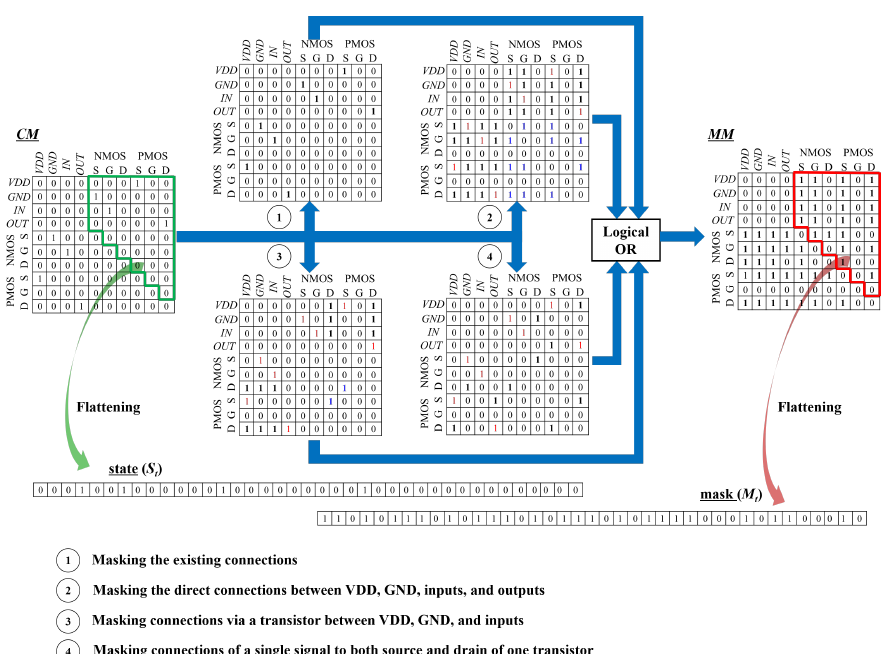
Figure 5. Mask generation scheme. Based on a given CM , MM is generated according to four masking criteria. The red 1s of matrices in the middle are existing connections in CM , and the blue 1s are possible connections via other nodes for each masking criterion. Finally, two vectors of S t and M t are produced by flattening the upper right regions of CM and MM , respectively.